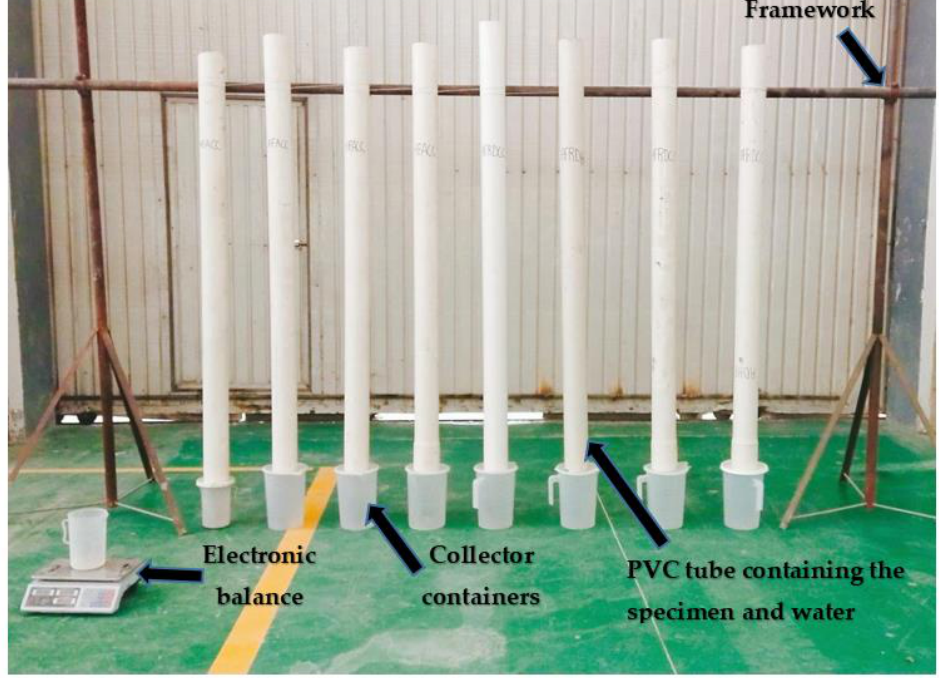
Figure 9. Framework for the permeability test.